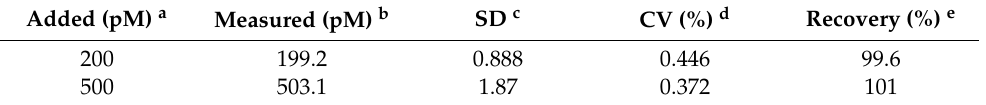
Table 2. Determination of target nucleic acid concentrations in human